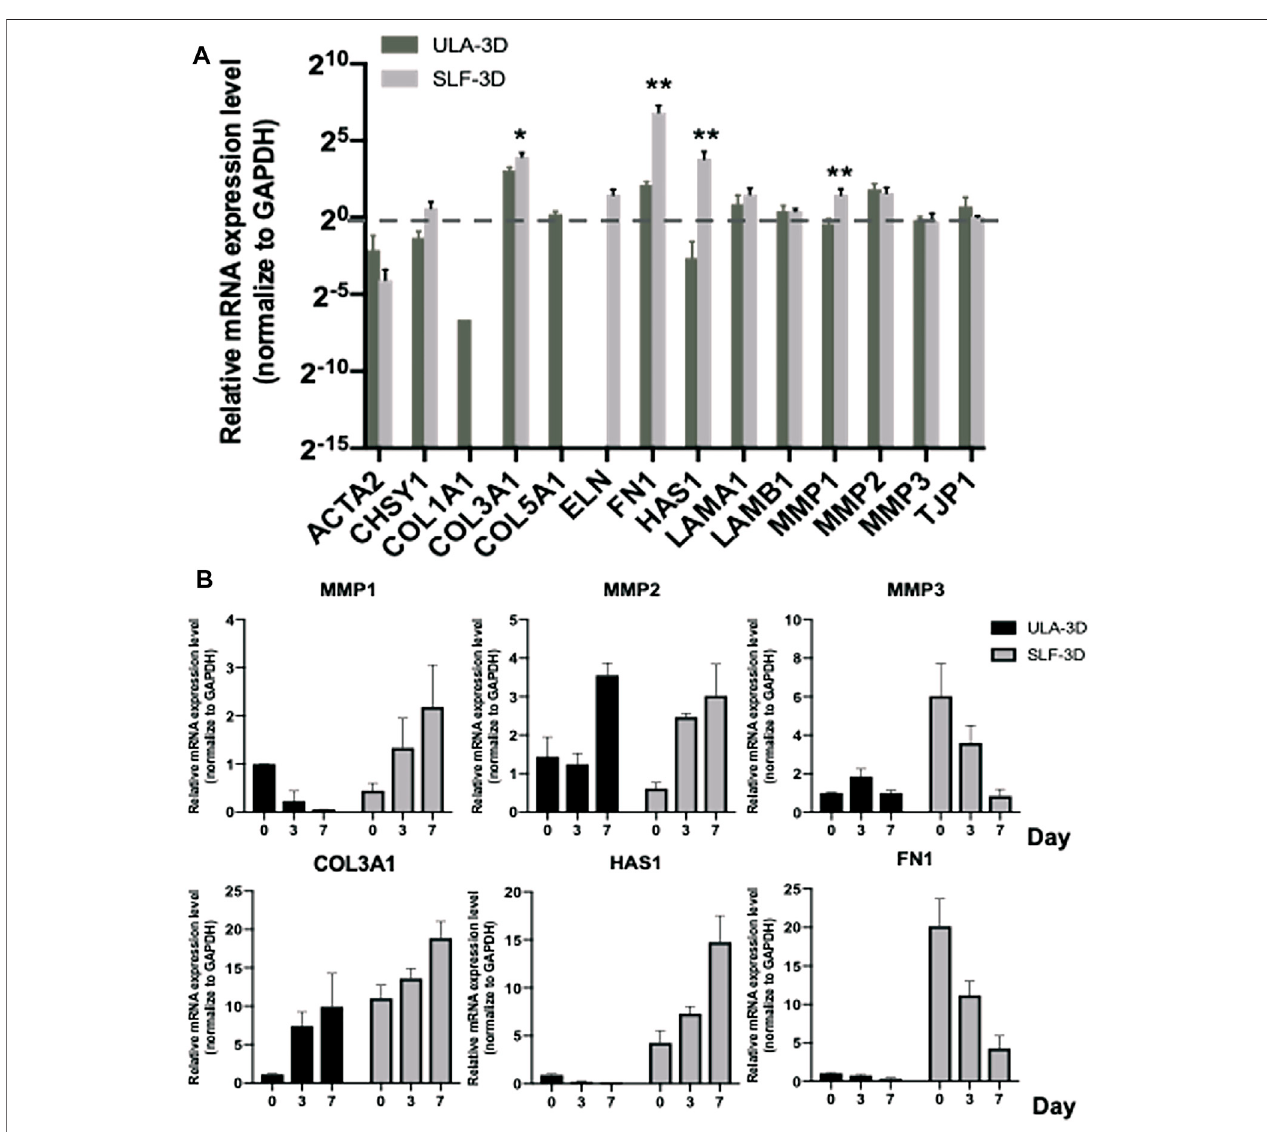
FIGURE 7 | ECM-related gene expression level of SLF-3D and ULA-3D spheroid. (A) ECM-related gene expression changes were evaluated by quantifying the mRNA level at 7 days in SLF-3D and ULA-3D ASC spheroids. (B) Spheroids were generated from SLF-3D and ULA-3D ASC spheroids at 0 days (12 h), 3 days, or 7 days and used for qPCR assay. Graphs show the means of three independent experiments, each performed in duplicate ± SE. n (cid:2) 3; ** p < 0.01.